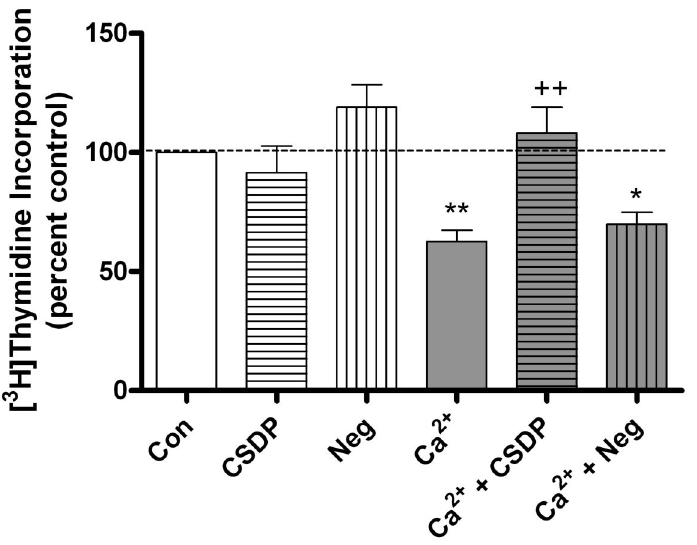
Figure 1. The caveolin-1 scaffolding domain peptide prevents the calcium-induced inhibition of DNA synthesis. Keratinocytes were treated for 24 hours with medium containing vehicle (0.1% DMS0) or 3 µM caveolin-1 scaffolding domain peptide (CSDP) or the negative control (Neg) in medium containing 25 µM calcium (Con) or 125 µM calcium (Ca 2+ ), as indicated. [ 3 H]Thymidine incorporation into DNA was measured as described in the Materials and Methods. Values are expressed as the percent control and represent the means ± SEM of 12 separate experiments performed in duplicate; *p<0.05, **p<0.01 versus the control value; ++p<0.01 versus calcium